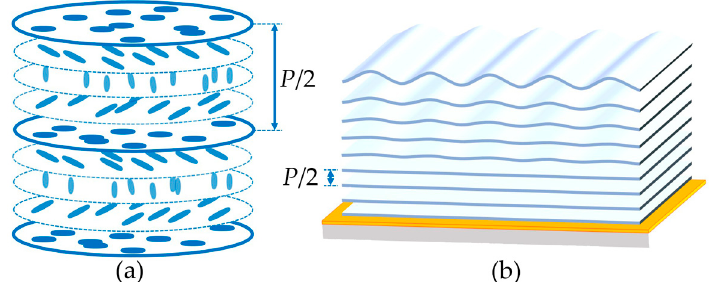
Figure 1. Schematics of ( a ) the cholesteric liquid crystal (CLC) helical structure and ( b ) the helical layers with a self-adapted distortion in a semi-free film. The distance between two adjacent layers equals to half a pitch. The orange layer represents the planar alignment film.